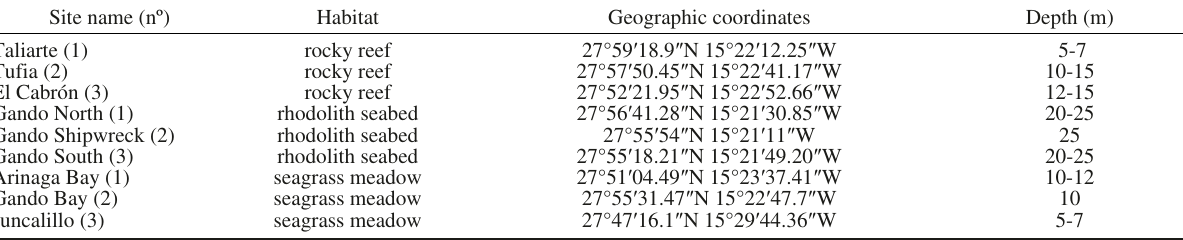
Table 1. – Location and depth of the sampling sites at Gran Canaria Island.